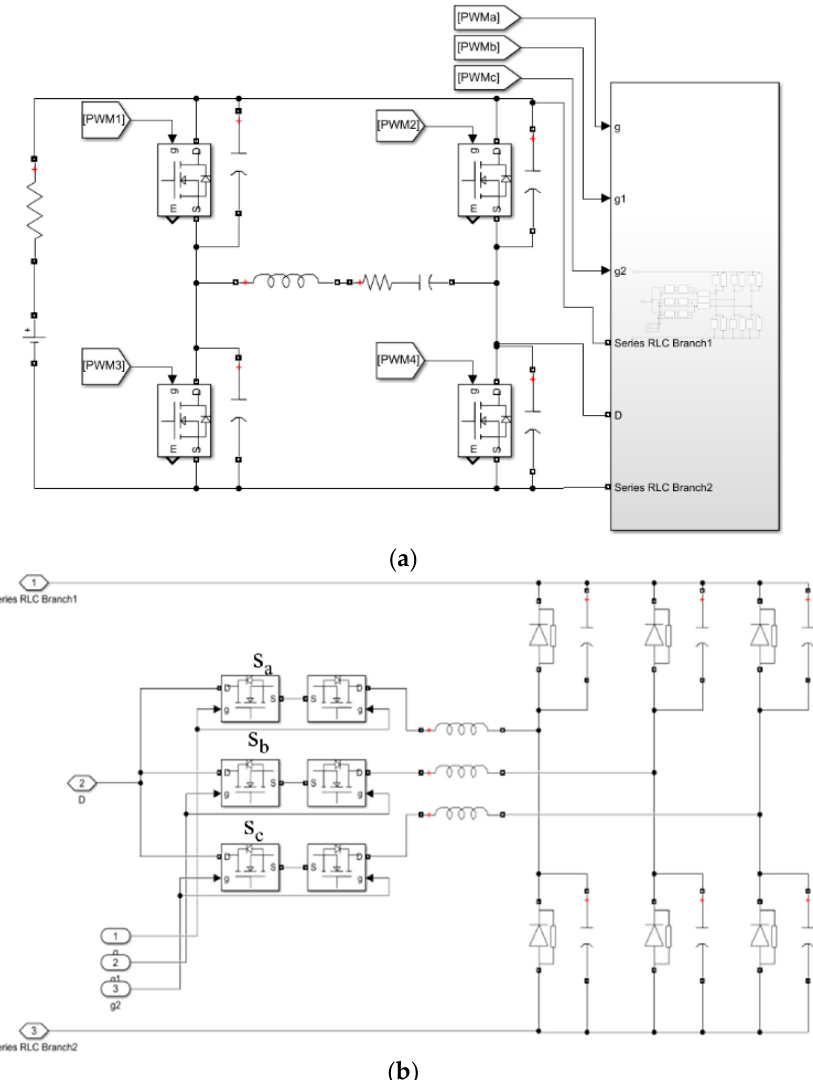
Figure 6. Simulation circuit model. ( a ) Main circuit diagram; ( b ) Auxiliary current source network.